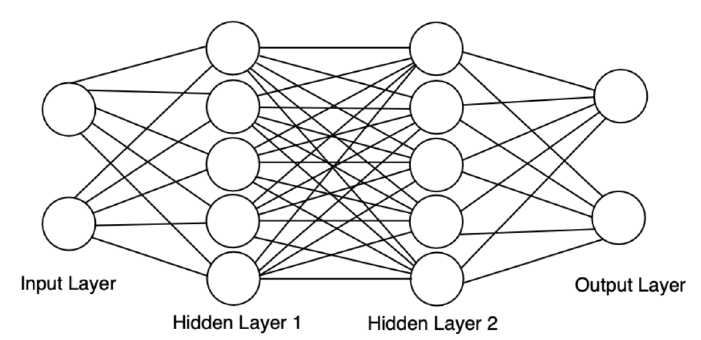
Figure 2 . An example of a two hidden layer fully connected neural network architecture. Each hidden layer represents matrix multiplication by a weight vector, the addition of a bias vector, and the element-wise application of an activation function, which introduces non-linearity into the function. In this work we used the Rectified Linear Unit (ReLU) activation